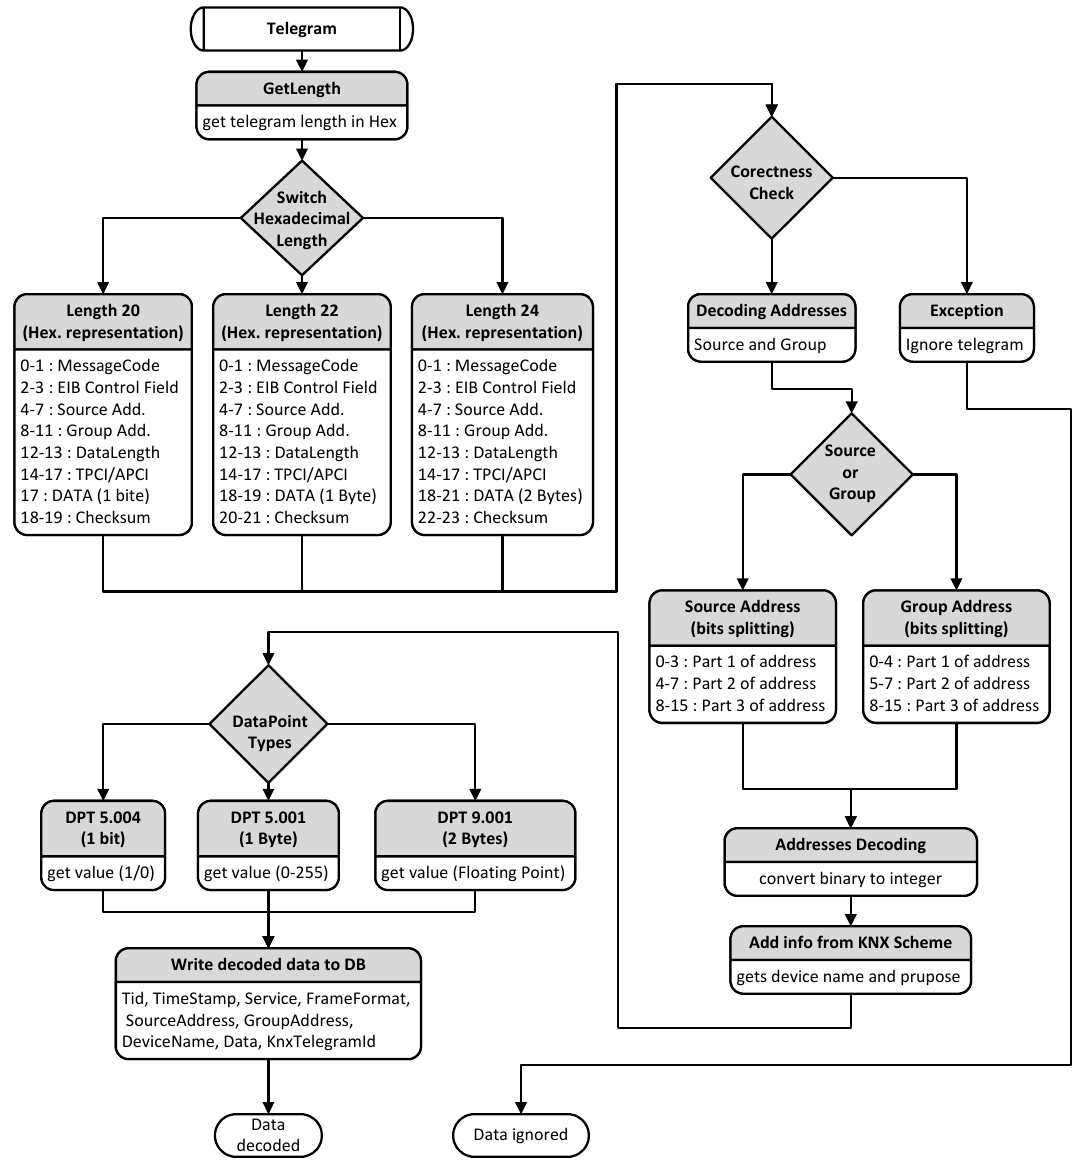
Figure 5. KNX Data Extractor block diagram.